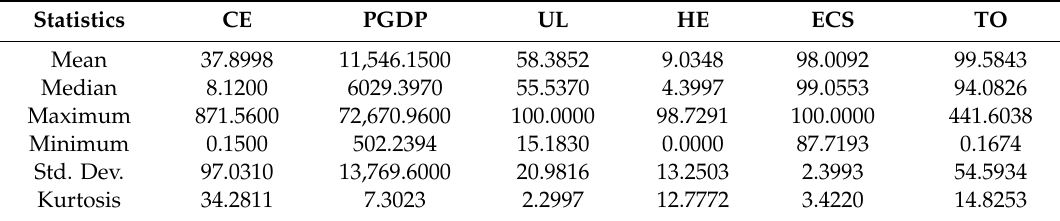
Table 3. Descriptive statistics of variables.